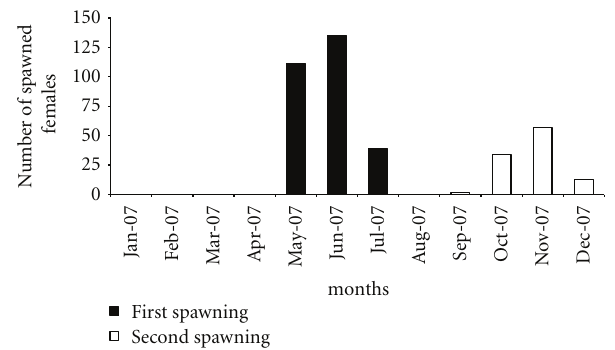
Figure 1: Spawning frequency of a biannual spawning female broodstock (Wt-03) of rainbow trout from